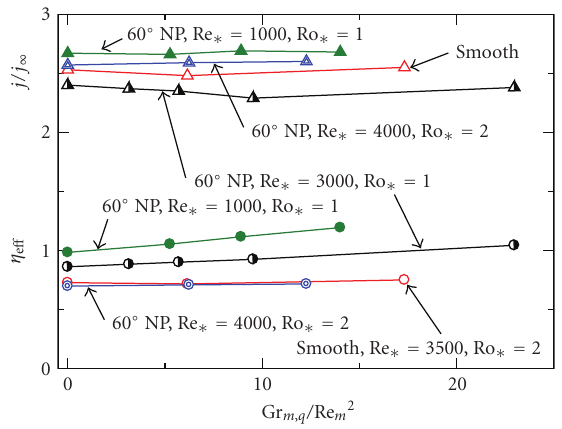
Figure 12: Buoyancy e ff ect on j factor and heat transfer e ffi ciency index (legend for the symbols are the same as that in Figure